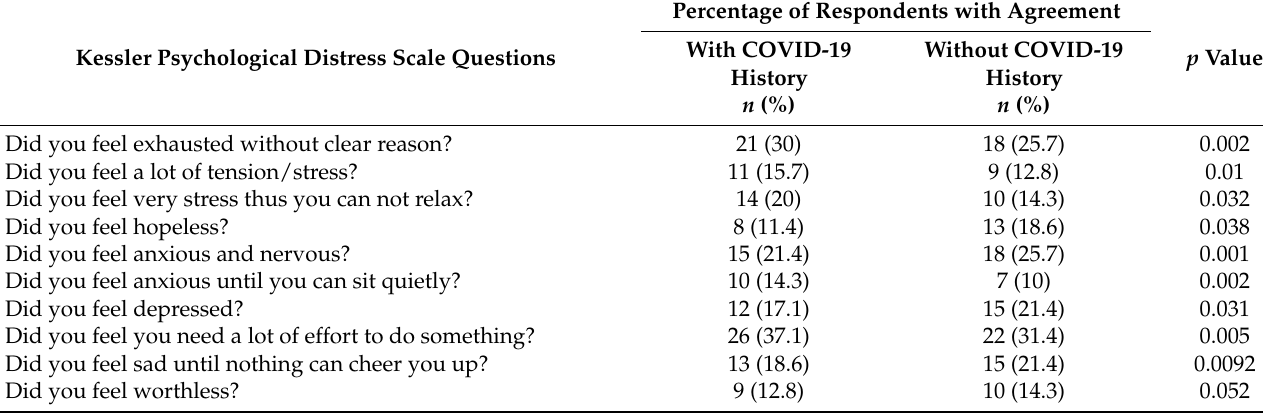
Table 7. Kessler psychological distress scale results.